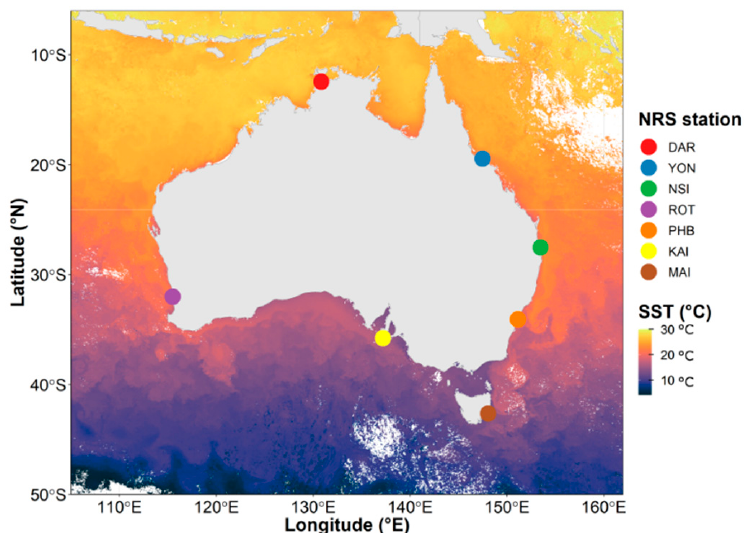
Figure 1. Variability of Sea Surface Temperatures Across the Seven National Reference Stations (NRS) Around Australia. The seven stations span 30-degree latitude and 20-degree longitude: from the northernmost site clockwise around Australia: Darwin (DAR), Yongala (YON), North Stradbroke Island (NSI), Port Hacking (PHB), Maria Island (MAI), Kangaroo Island (KAI) and Rottnest Island (ROT). Ocean colours represent the Sea surface temperature ( ◦ C) of a single date from MODIS ocean colour (https://oceancolor.gsfc.nasa.gov/l3/ (accessed on 23/08/2021)).